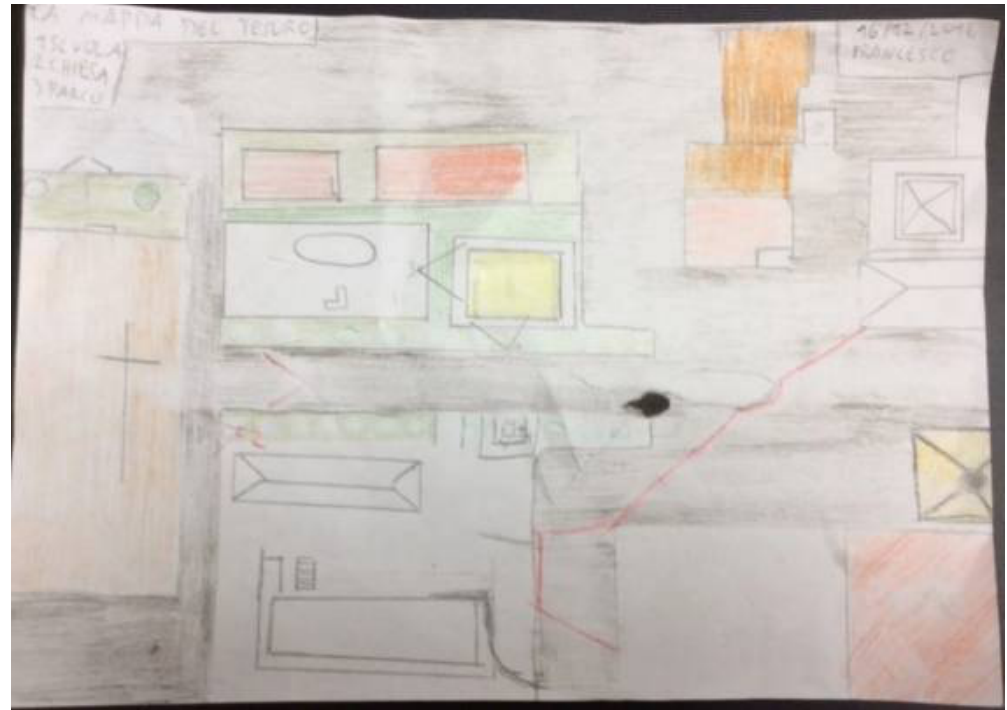
Figure 9. Gualdo, the school with the surrounding (drawing